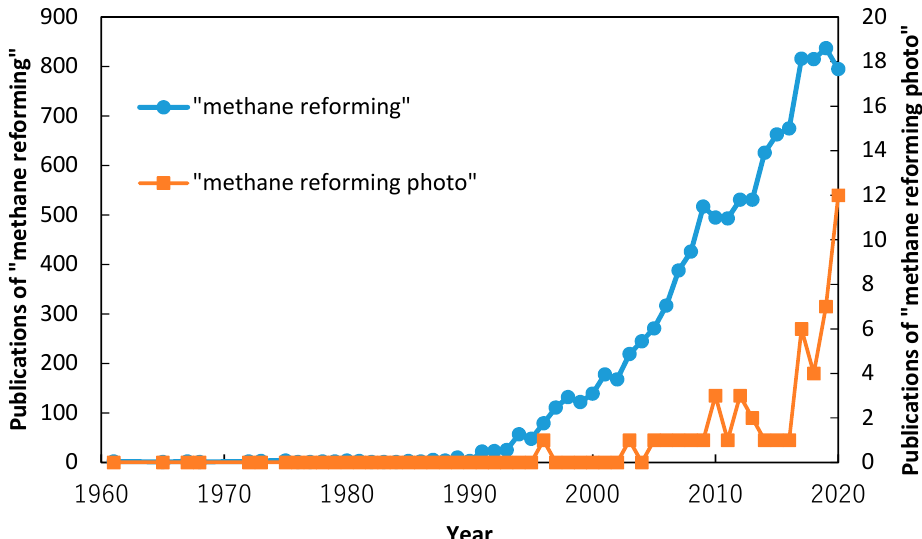
Figure 2. Number of publications found using the search terms “methane reforming” and “methane reforming photo” in Web of Science [15].